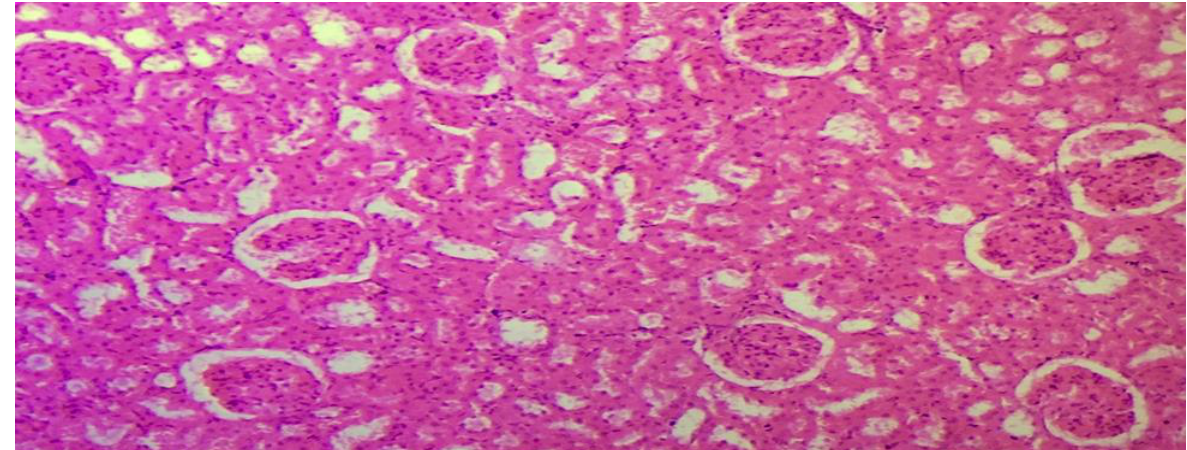
Fig. 1.1. Photomicrograph of a kidney showing renal tubules (A) and Glomeruli (B) (Control group